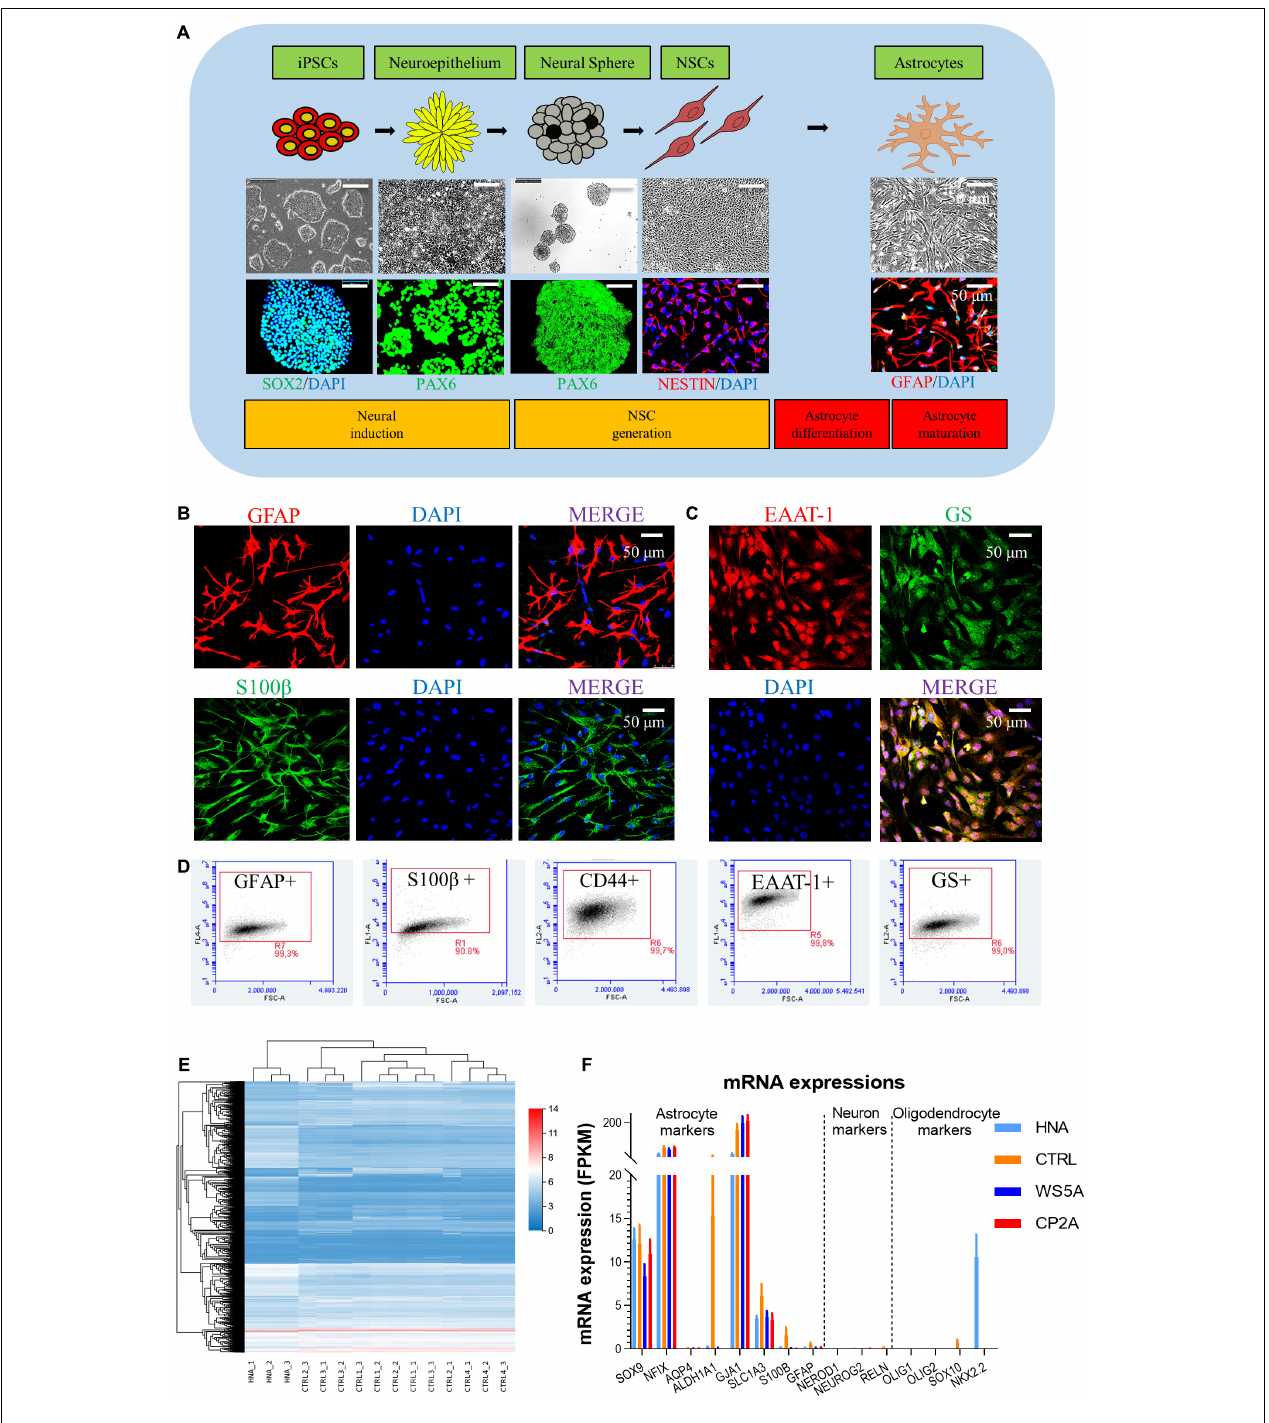
FIGURE 1 | Generation and characterization of patient-specific astrocytes carrying POLG mutations. (A) Schematic of dual differentiation and seeding paradigm for astrocytes (upper panel), representative phase-contrast images (middle panel) and immunostaining for specific stages during neural induction from iPSCs to astrocytes (lower panel). (B,C) Representative phase-contrast images and confocal images of immunostaining for GFAP (red), S100 β (green), EAAT-1 (red), and GS (green). Nuclei are stained with DAPI (blue). Scale bar is 50 µ m. (D) Flow cytometric analysis for percentage of the positive cells expressing GFAP, S100 β , CD44, EAAT-1, and GS. (E) Clustering heat map [log (value + 1)] for DEGs in HNA and control iPSC-derived astrocytes. (F) mRNA expression of astrocyte, neuron, and oligodendrocyte-related genes in HNA and all iPSC-derived astrocytes. The different markers are listed on the x -axis, and mRNA expression is on the y -axis. Results are expressed as fragments per kilobase million (FPKM). Data information: The data in B–D represent one clone from AG05836 control. The data in E represent HNA, four different control astrocytes with three clones from Detroit 551 control and one clone from AG05836 control. The data in F represent HNA, four different control astrocytes with three clones from Detroit 551 control and one clone from AG05836 control, three clones from WS5A and two clones from CP2A.